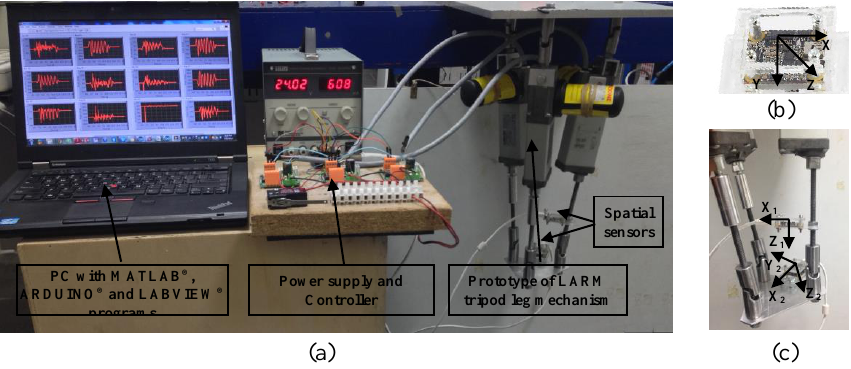
Figure 4. Layout for a foot motion control system of the proposed LARM tripod leg mechanism for experimental tests: (a) a layout of whole system; (b) a Phidgets ® spatial 3/3/3 1044_0 sensor; (c) Location of two sensors.